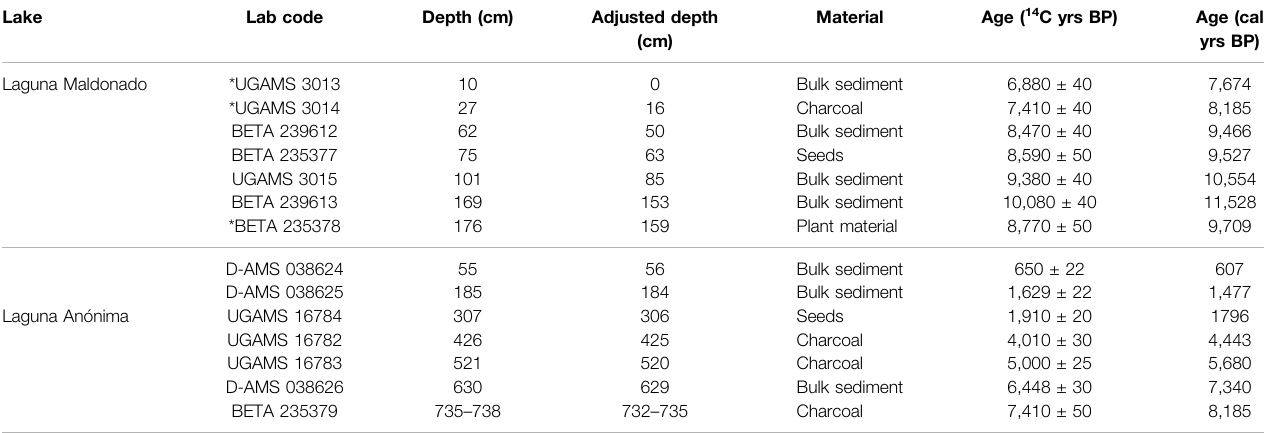
TABLE 1 | AMS radiocarbon ages from cores LMA0608B and LLA 0607A from Laguna Maldonado and Laguna Anónima, respectively. The data marked with * were not included in the age – depth model (see Materials and Methods ).